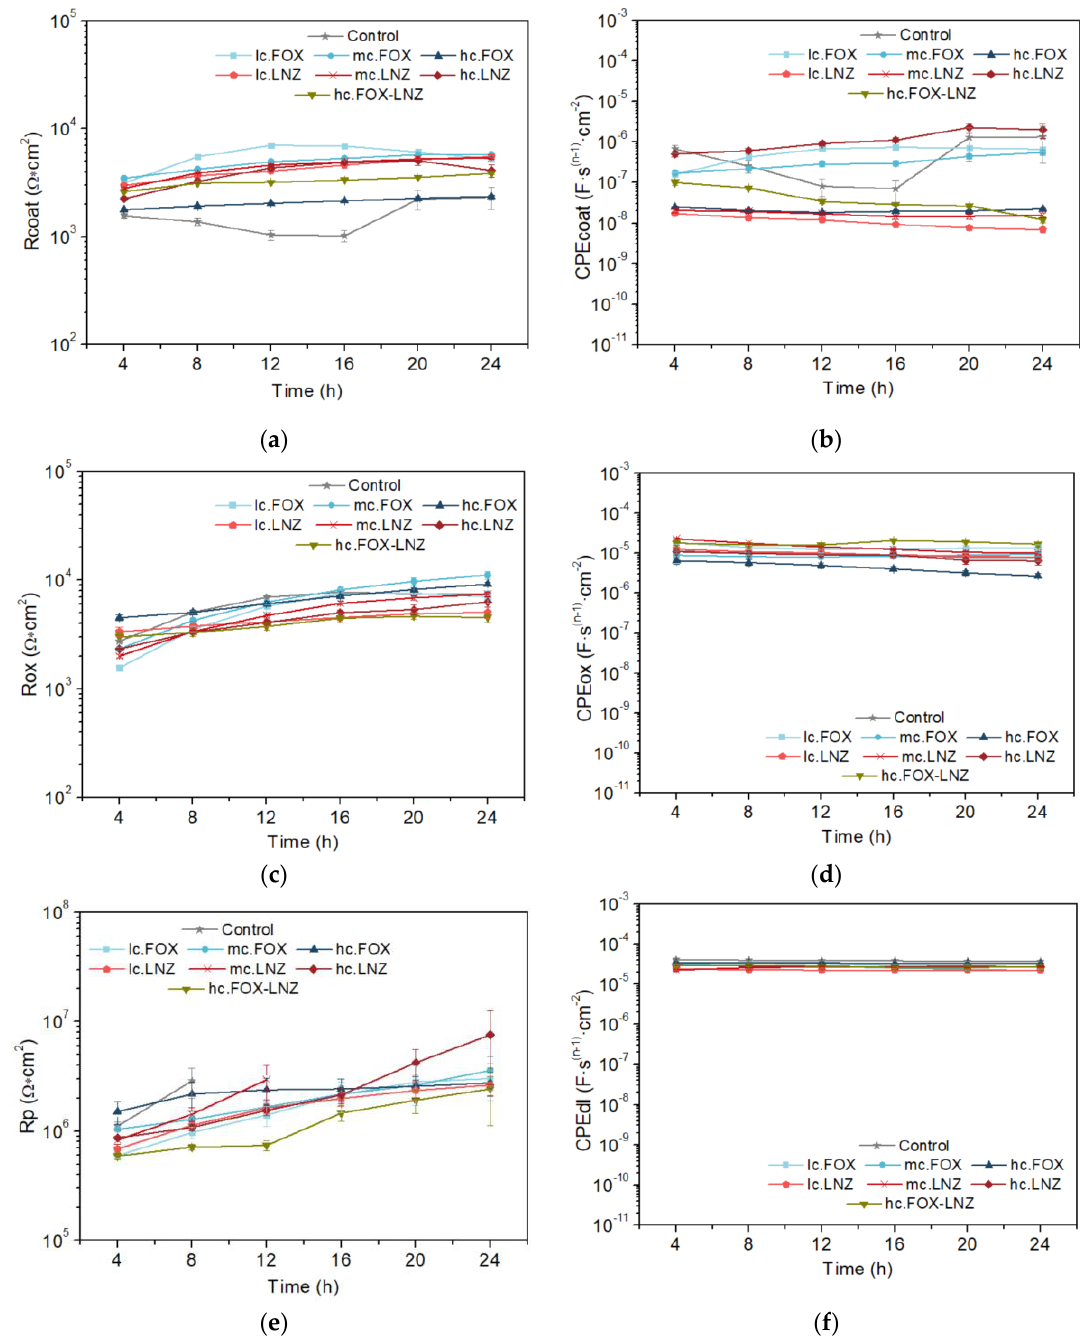
Figure 4. Evolution vs. time of exposure in the electrolyte of ( a ) coating resistance, R coat ; ( b ) constant phase element of the coating, CPE coat (0.53 < n < 1); ( c ) resistance of oxide layer (corrosion products),